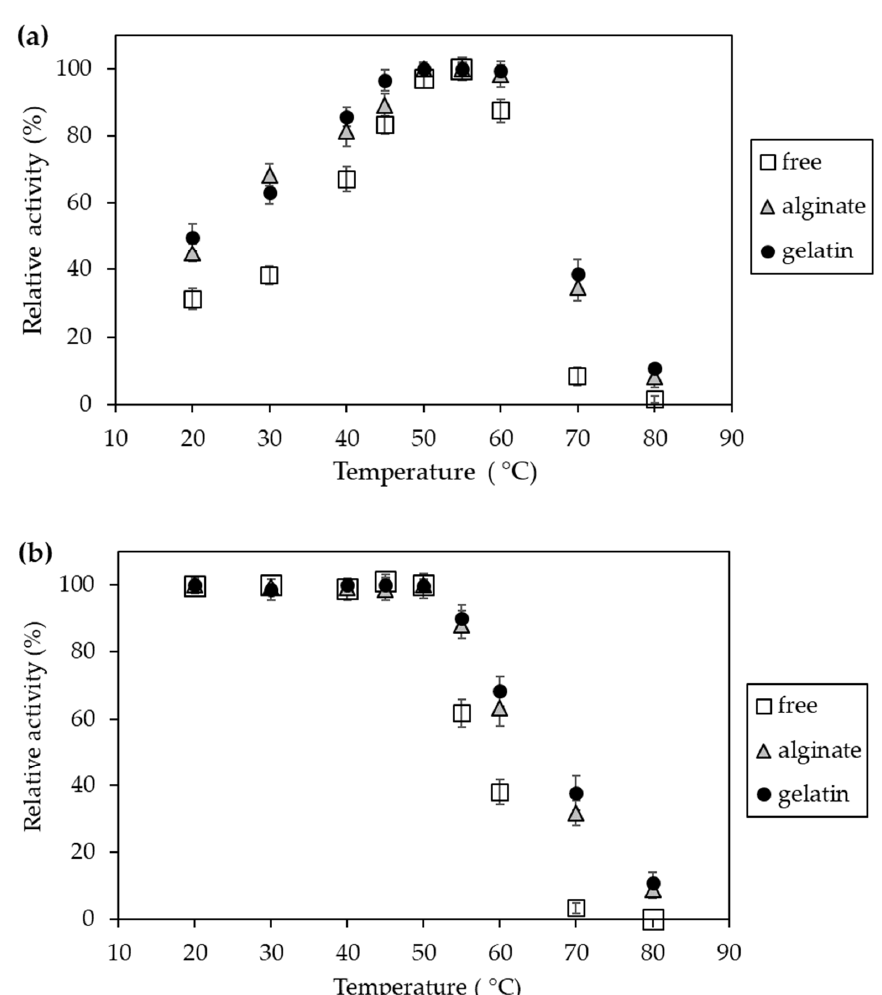
Figure 9. Effect of temperature on relative activity ( a ) and stability ( b ) of free invertase (white square) and immobilized in alginate (grey triangle) and gelatin-based hydrogels (black circle). The highest activity value obtained during the experiments was assumed to be 100%. Catalysts 2020 , 9 , x FOR PEER REVIEW